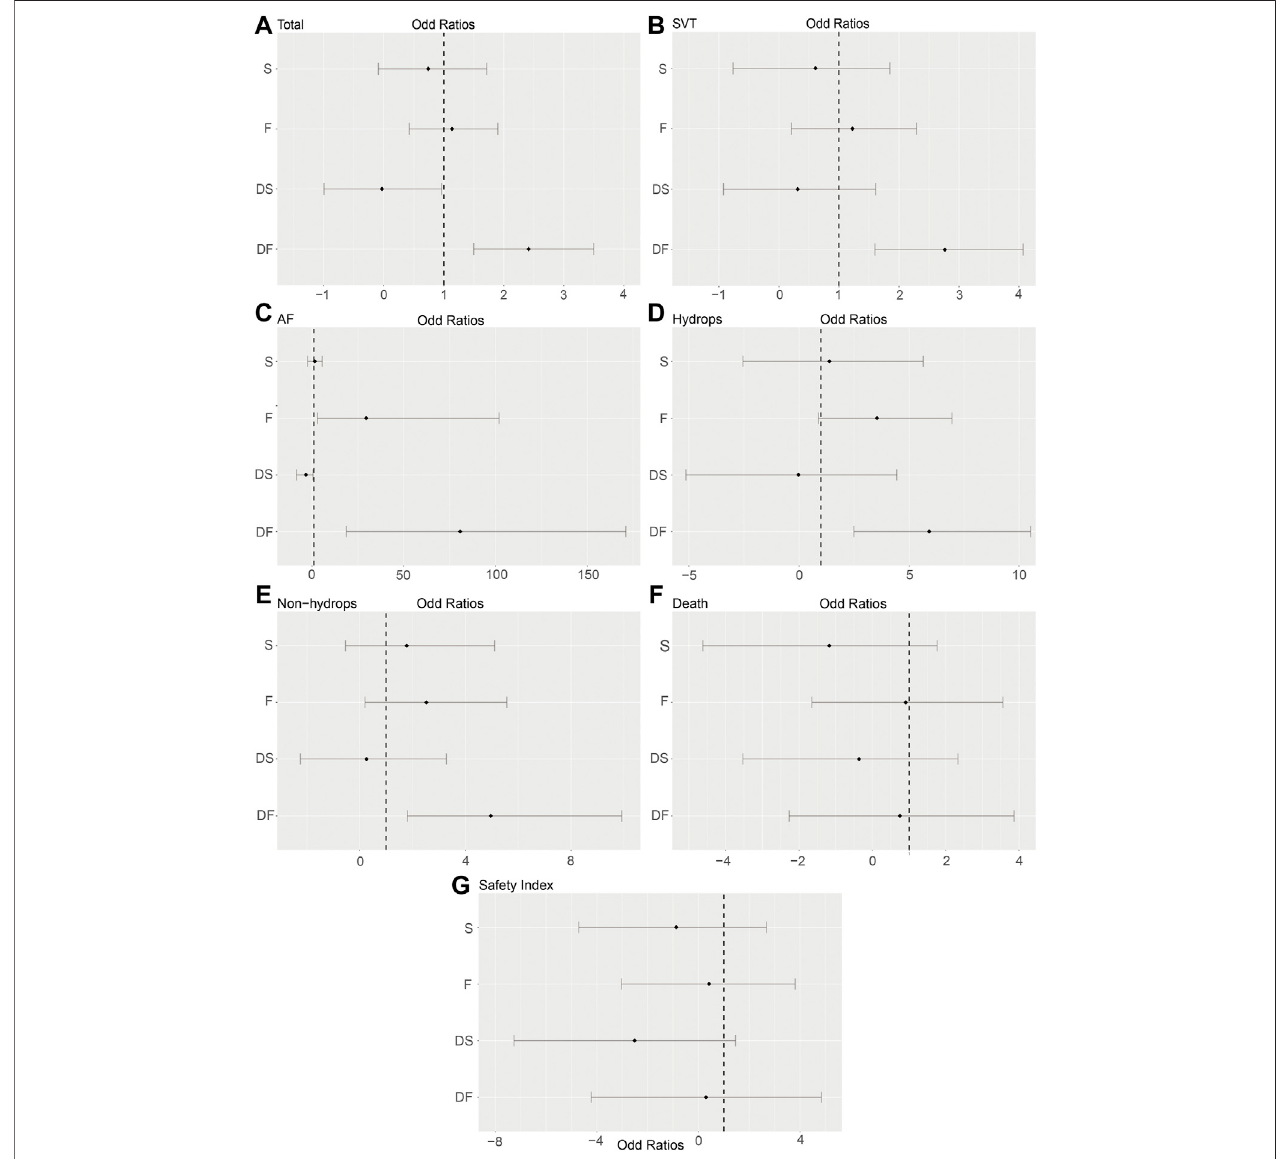
FIGURE3 | Forest plotsof theenrolled analyses. The forest plotsshowed odds ratios (ORs) and 95% credible intervals (95% CrI) comparingthe effectivenessand risks among fi ve regimens, using D as the baseline reference (OR = 1). (A) Total group. (B) SVT group. (C) AF group. (D) Hydrops group. (E) Non-hydrops group. (F) Death rate in the total group. (G) Safety index in the total group. D, digoxin monotherapy; DF, digoxin and fl ecainide combination therapy; DS, digoxin and sotalol combination therapy; F, fl ecainide monotherapy; S, sotalol monotherapy; SVT, supraventricular tachycardia; AF atrial fl utter.